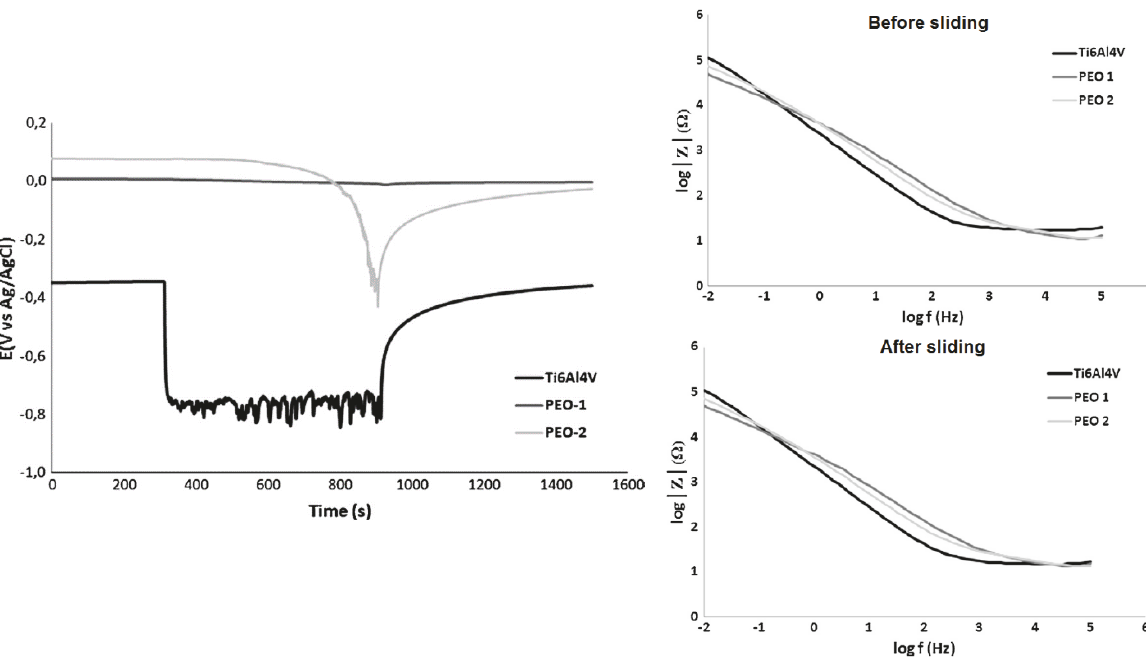
Figure 10: Potential shift towards more negative values due to a sliding process for a Ti6Al4V alloy with and without TiO 2 coatings generated by PEO technique in PBS solution (left) and impedance spectroscopy measurements obtained before and after sliding (right). The electrochemical state of the TiO 2 coating surface was not highly affected by sliding, and no influence of sliding on the corrosion resistance of either sample was observed